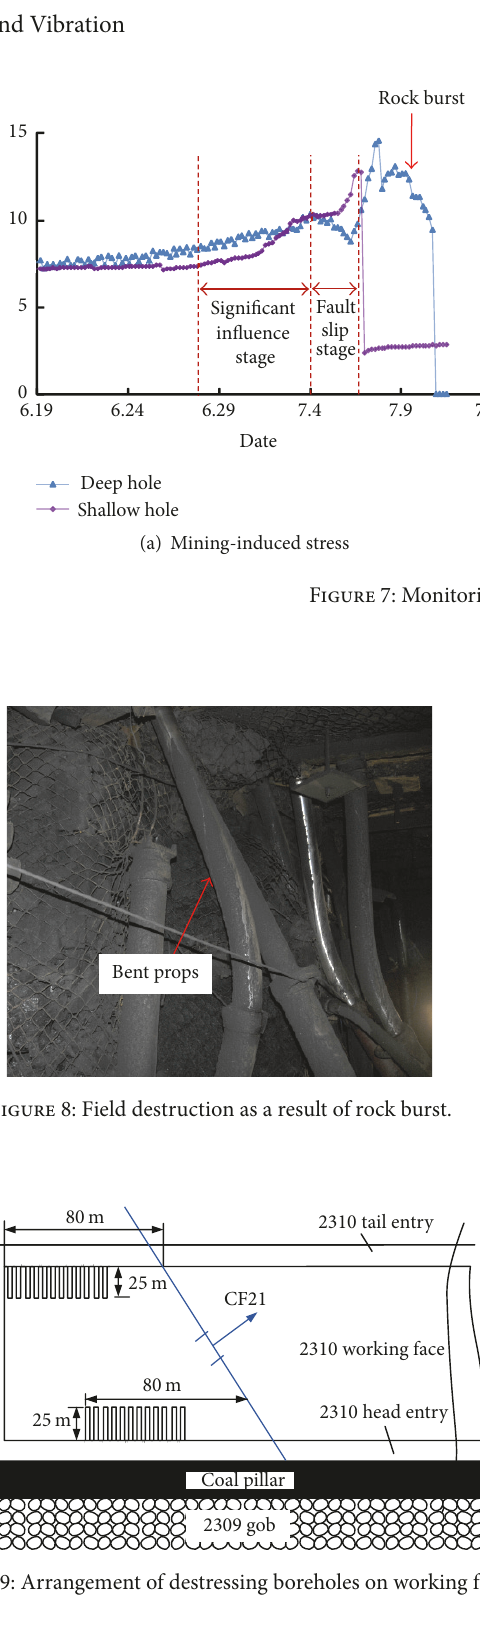
( 4 ) Considering the geological conditions of Suncun Coal Mine, large-diameter borehole was adopted to perform pressure relief. The peak value of seismic energy of working